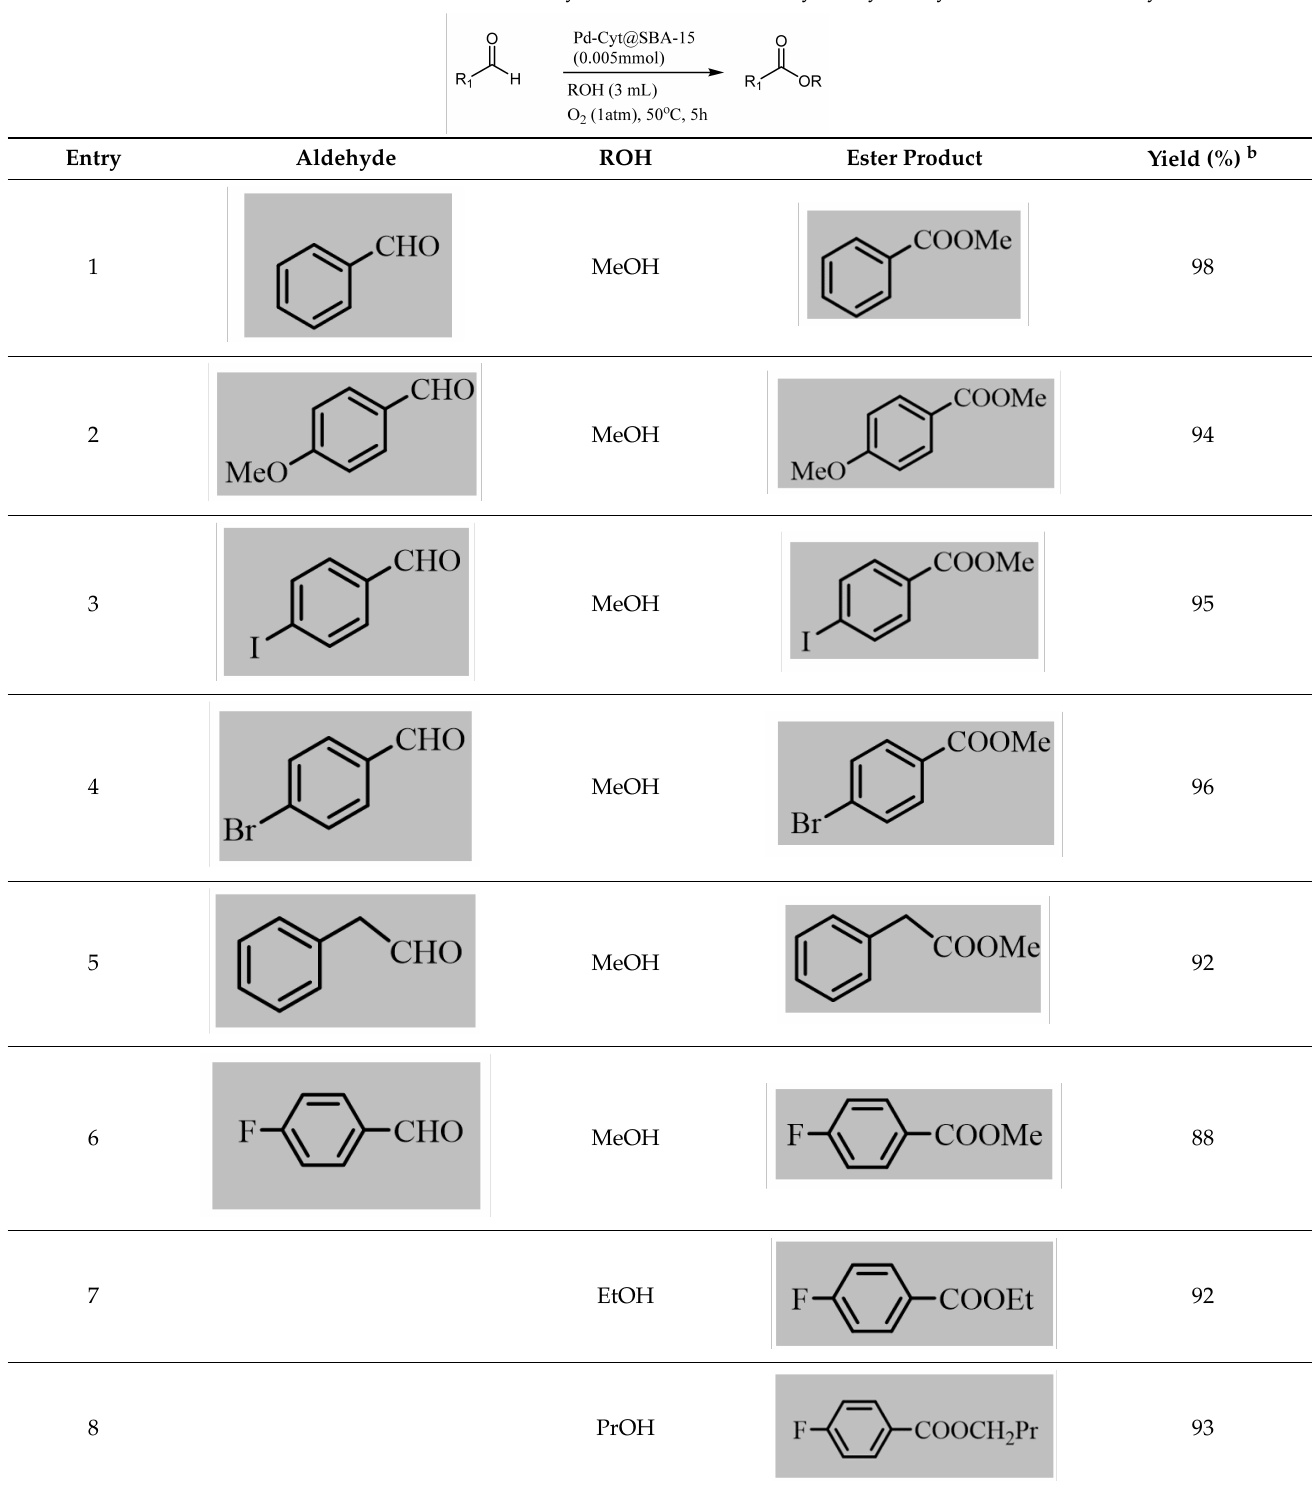
Table 2. Oxidative esterification reaction of aldehydes with alcohols catalyzed by Pd-Cyt@SBA-15 nanocatalyst a